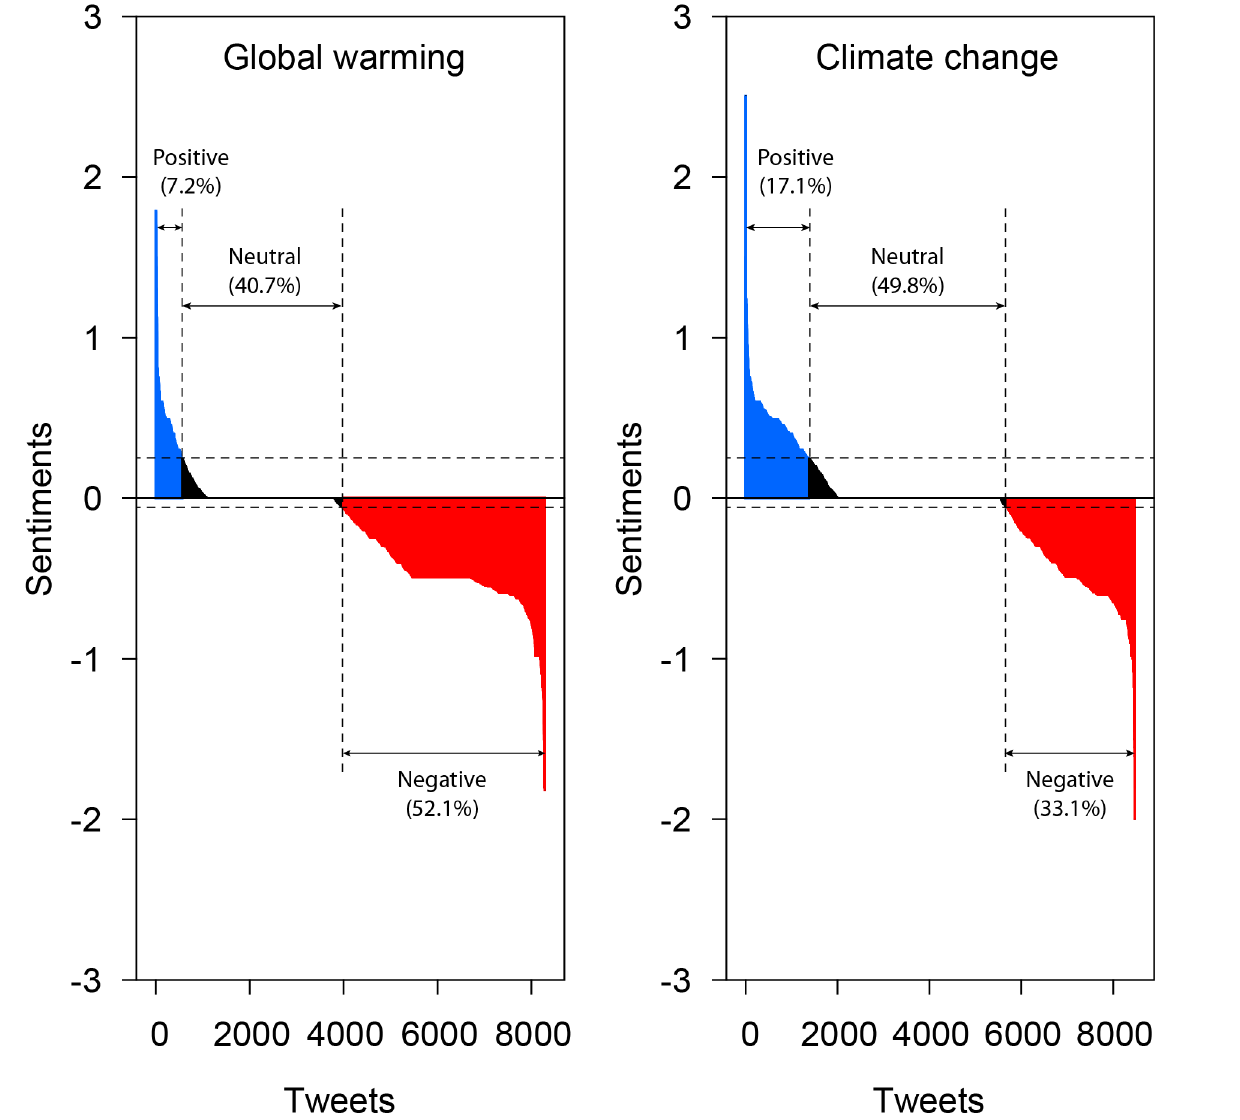
Fig 2. Distribution of positive, neutral, and negative sentiments in tweets about global warming and climate